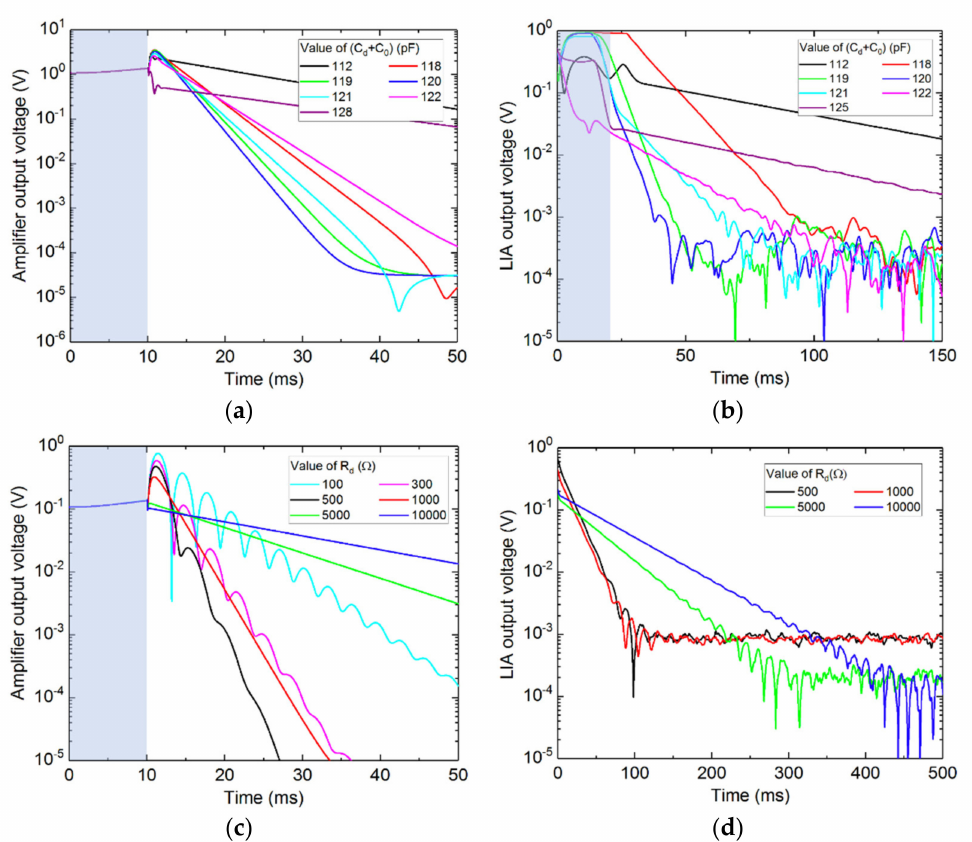
Figure 4. Simulated (left) and experimental (right). QTF response with the damping circuit while varying the damping capacitance ( a , b ) (with R d = 500 Ω ) and the effective damping resistance ( c , d ) (with C d + C 0 = 120 pF). The electrical excitation takes place during about 10 ms as represented by the blue area. Then, the electrical excitation is stopped and the QTF is connected to the damping circuit. For the experiments, the QTF employed was a NC38LF (Fox Electronics, Fort Myers, FL, USA), with a resonant frequency of 32,757 Hz and a quality factor of about 11,000.